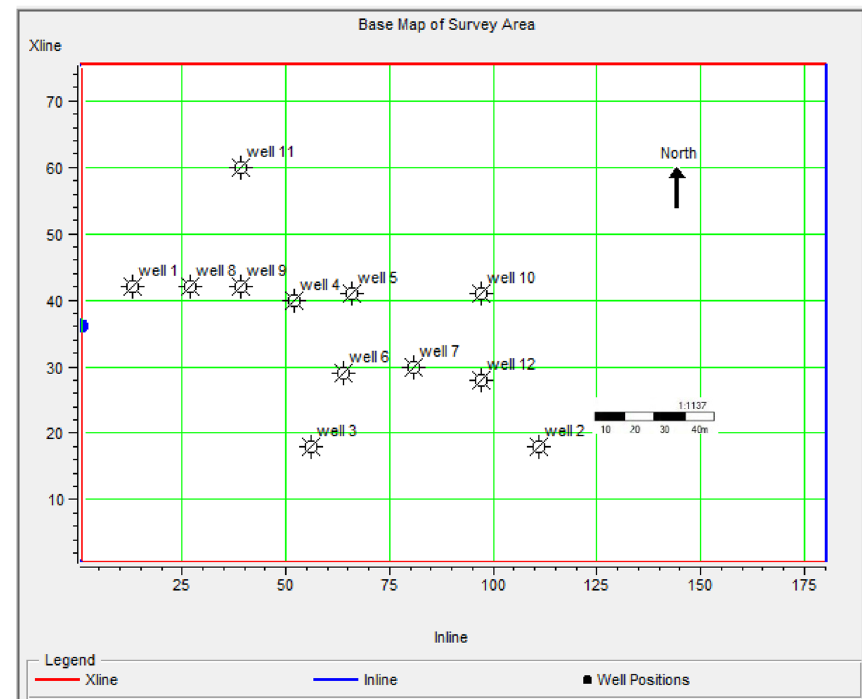
Fig. 2 Map of the locations of wells drilled in the area of seismic acquisition (HRS)